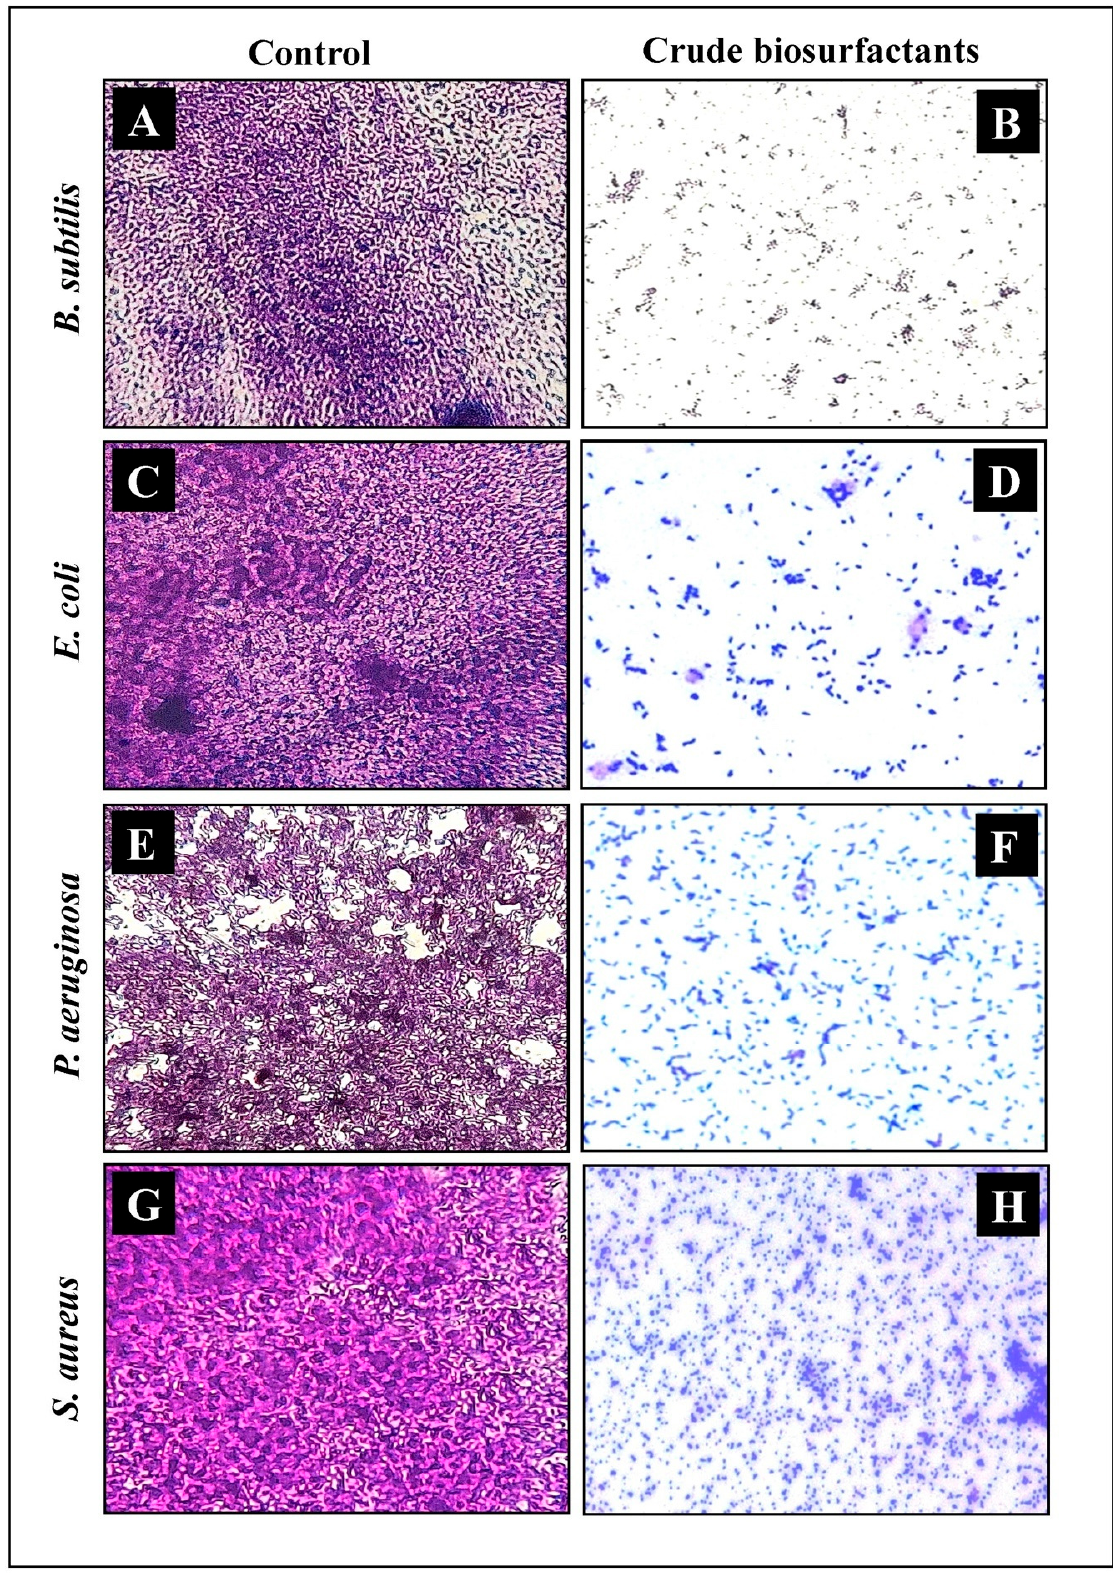
Figure 7. Micrographs of disrupted matured biofilms of the test pathogens by P. pentosaceus crude biosurfactant formed on the glass surface at their respective MICs under LM. Growth control ( A , C , E , G ), with the P. pentosaceus crude biosurfactant ( B , D , F , H ).